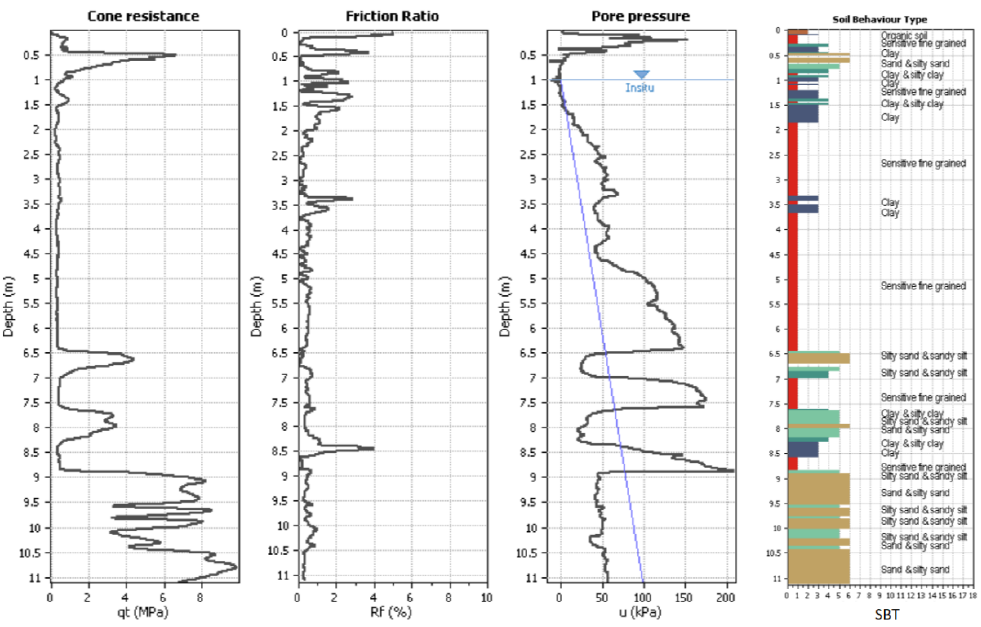
Figure 10. CPT characterization and SBT plot for Site 1 (after Anderson [40]).